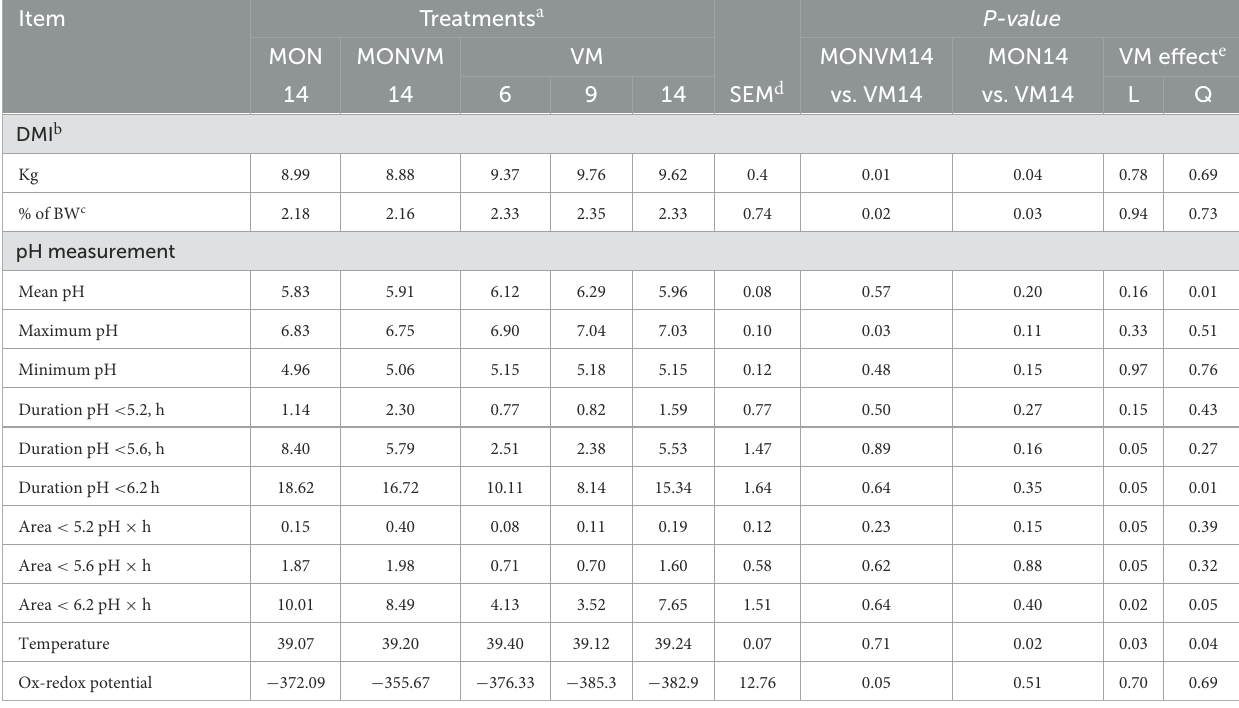
TABLE 2 Dry matter intake and ruminal pH of rumen cannulated Nellore cattle fed high concentrate diets containing sodium monensin (MON), virginiamycin (VM) or both on day 16 of the experimental period (or both during finishing